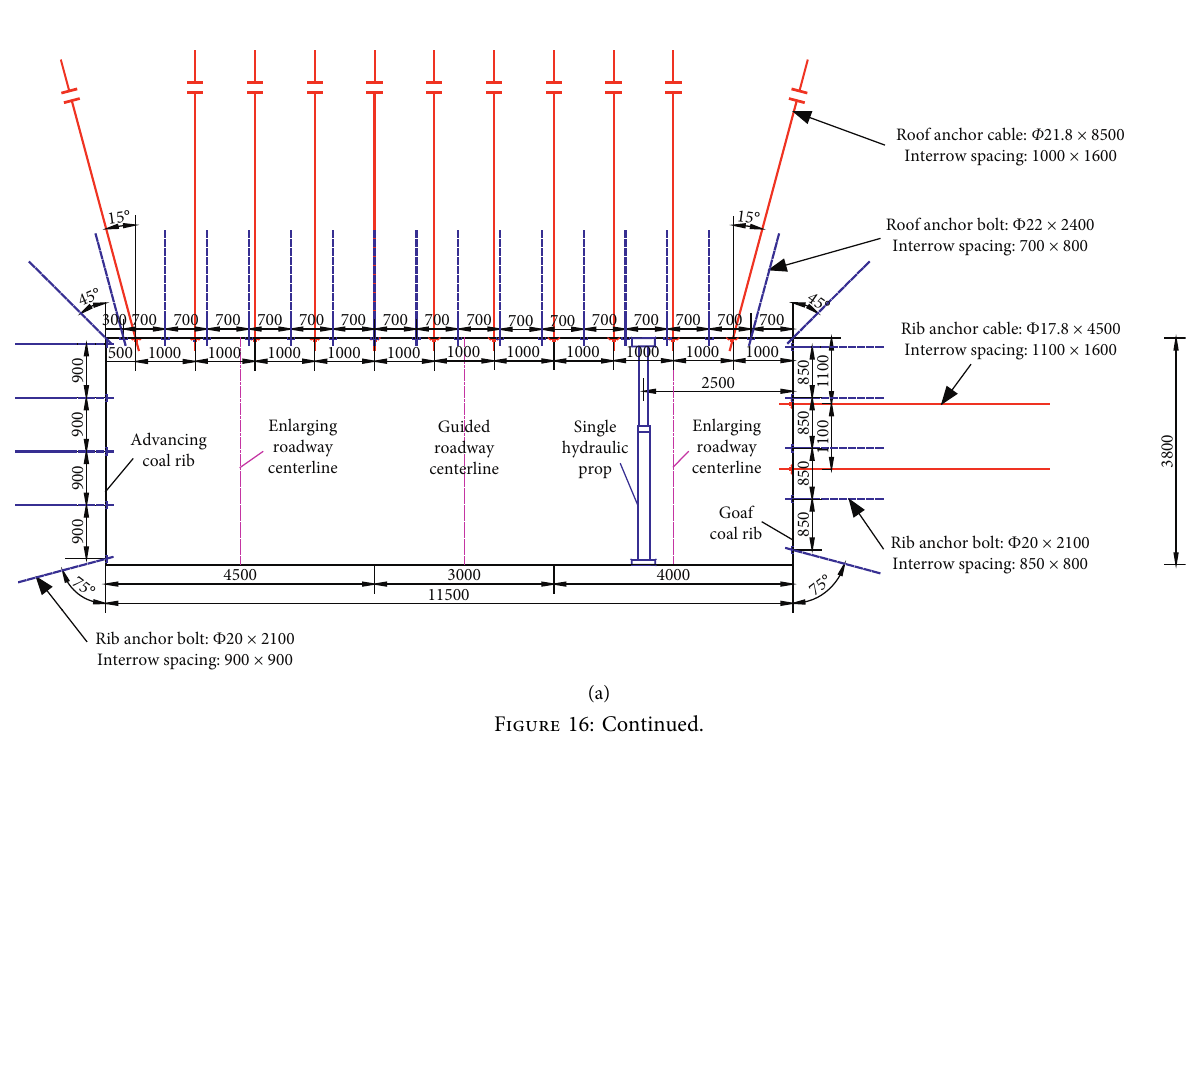
Guided roadway centerline